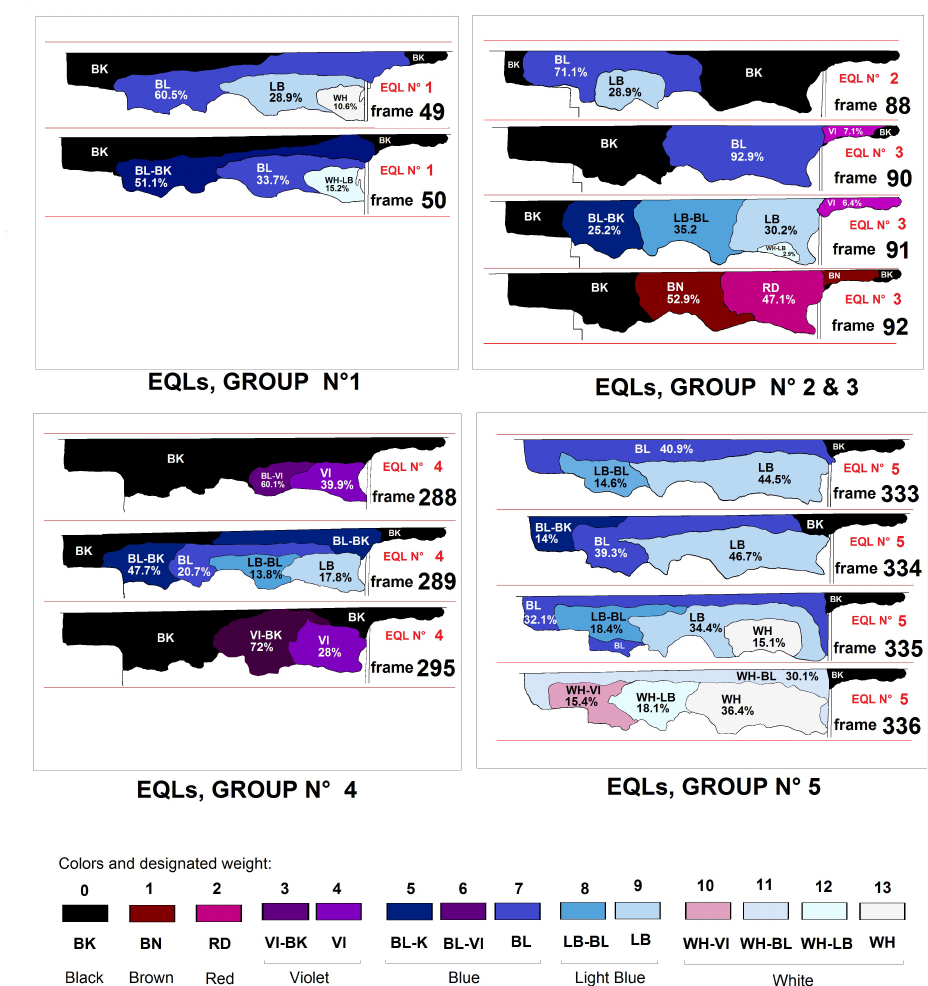
Fig. 8. Colors of the Lights. These four groups depict the five main lights shown in Fig. 9, analyzed frame by frame. Groups 2 & 3 are together since they occurred almost simultaneously, but arriving from slightly different directions. A color scale is also provided.